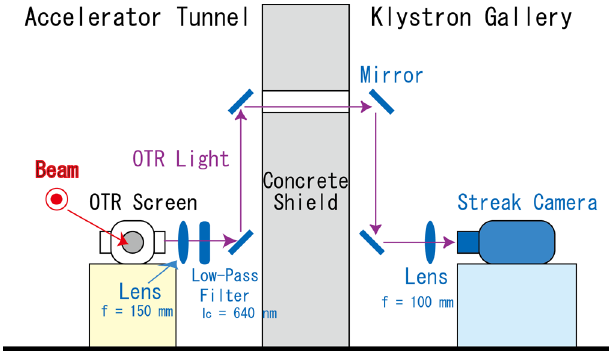
22. Electron charge-amount dependence of the pyrode- tector output. The intensity clearly changes in proportion to the square of the charge amount.